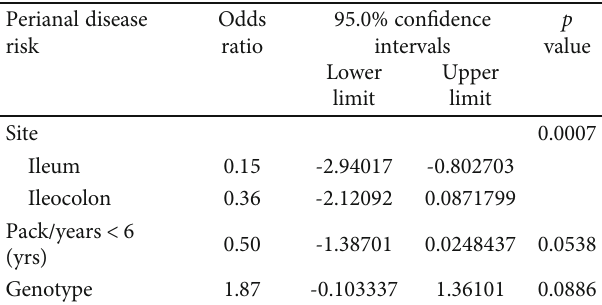
Table 4: Independent variables associated to the perianal disease